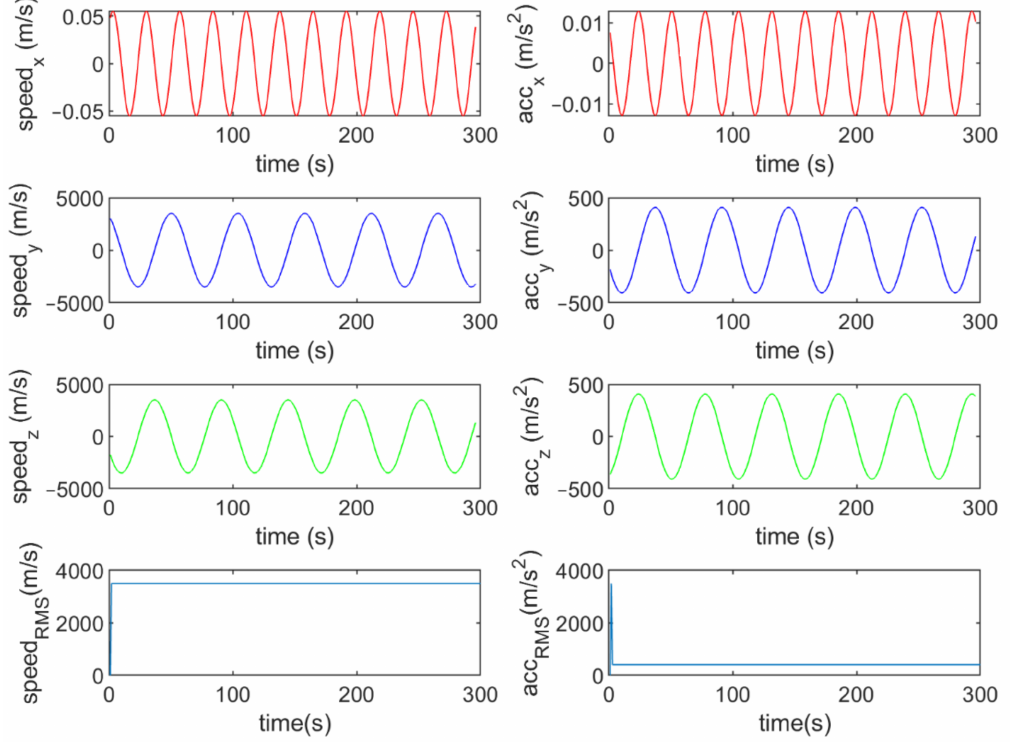
Figure 13. The speed and acceleration components in the fourth